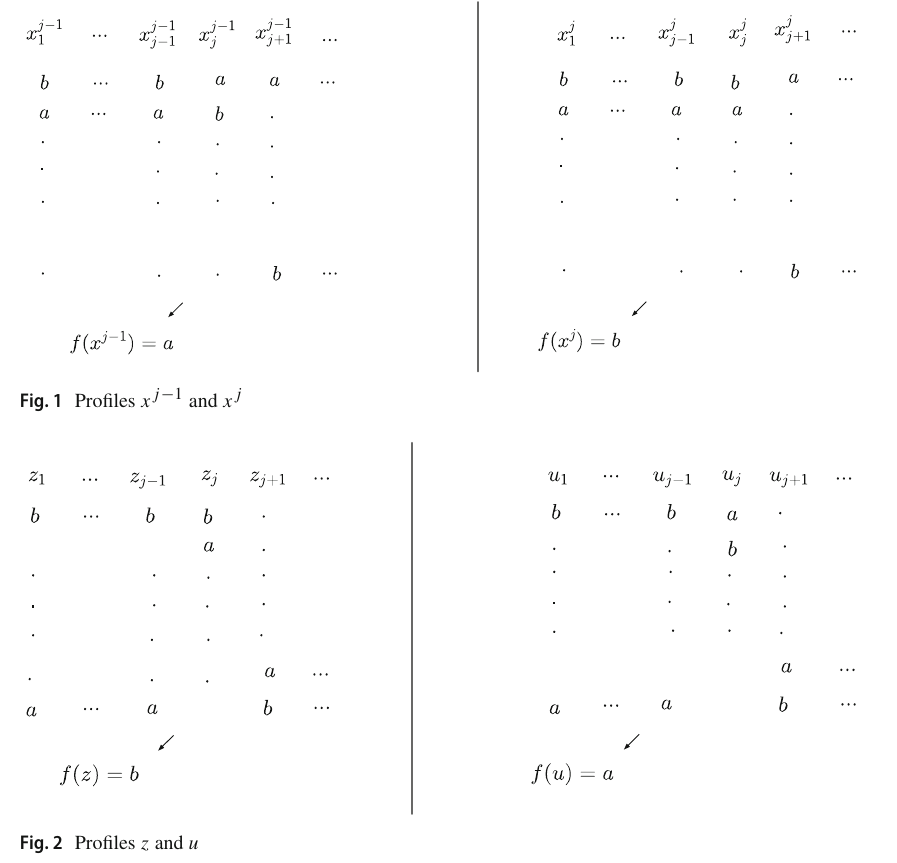
Fig. 1 Profiles x j − 1 and x